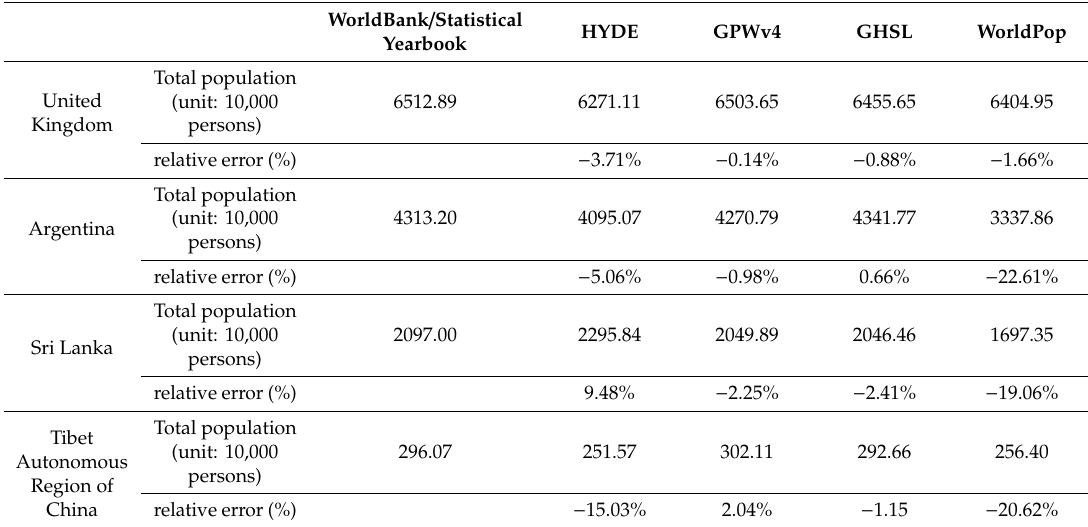
Table 4. Total population and estimation deviation of